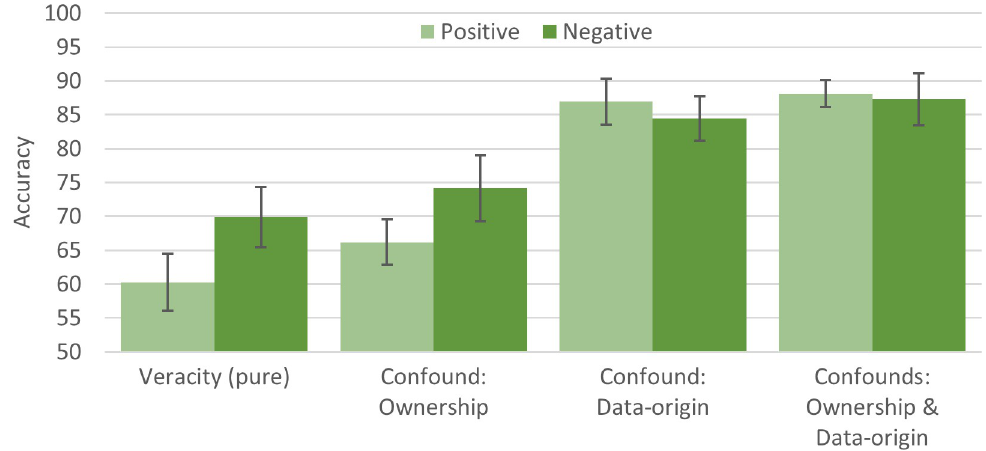
Fig 3. Classification accuracies (with 99% CI) of analyses 1 ( veracity ), 4 ( veracity , ownership ), 5 ( veracity , data- origin ), and 6 ( veracity , ownership , data-origin ); accuracy ranges from 50% (chance level) to 100%.